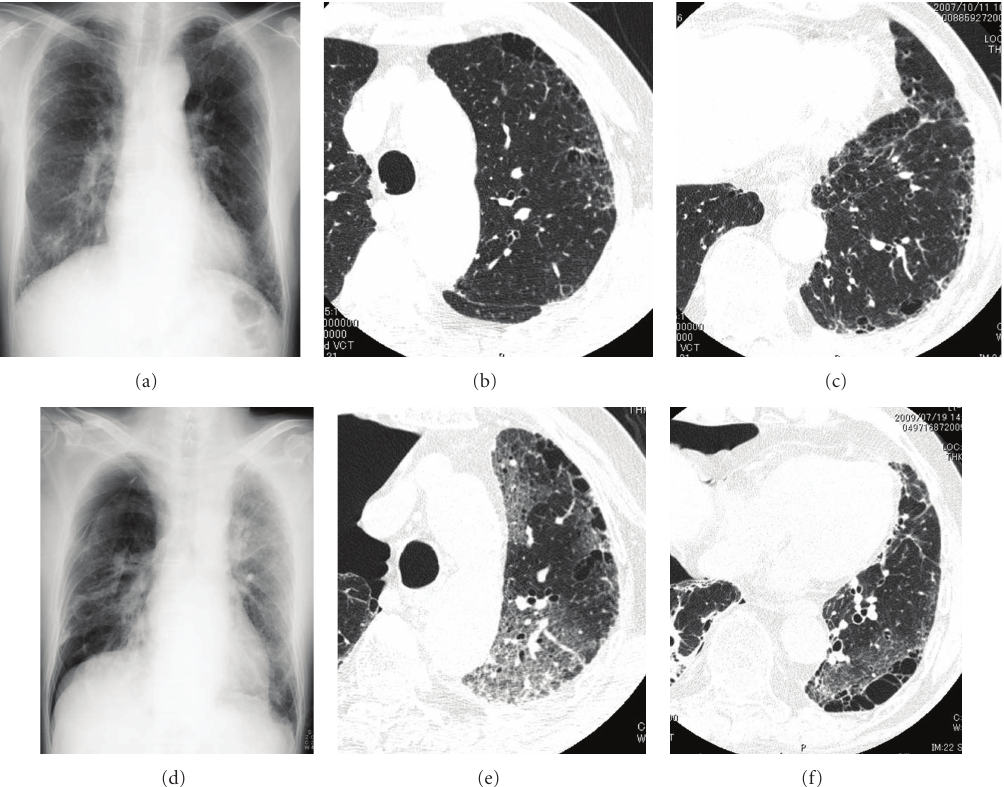
Figure 7: Emphysema with fibrosis, acute exacerbation by anticancer drug. (a)–(e) Imaging findings before acute exacerbation. (a) Chest X-ray shows normal volume of bilateral lungs. There is reticular opacity in bilateral lower lung fields. (b), (c) High-resolution CT (HRCT). In upper lung, centrilobular emphysema, subpleural cyst, and profuse centrilobular small nodular opacities are identified. In lower lung, subpleural cysts and reticular opacity are noted abutting chest wall, most compatible with UIP pattern. (d)–(f) Imaging findings at acute exacerbation. (d) Chest X-ray shows di ff use ground glass opacity in the left entire lung. Pneumothorax is noted on right side. (e), (f) HRCT shows di ff use ground glass opacity overlapping preexisting interstitial